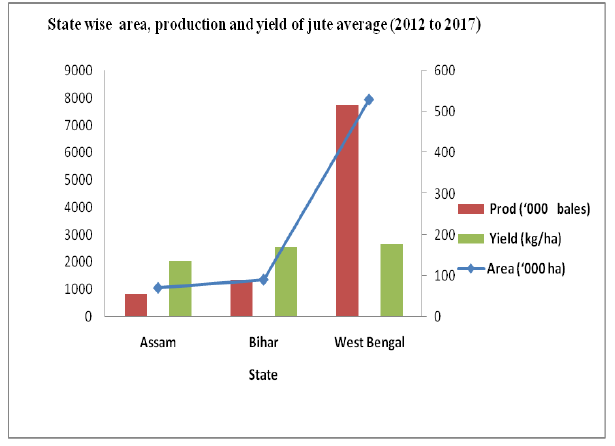
Figure 2. State-wise average (2012 to 2017) Jute Area, Production and Yield